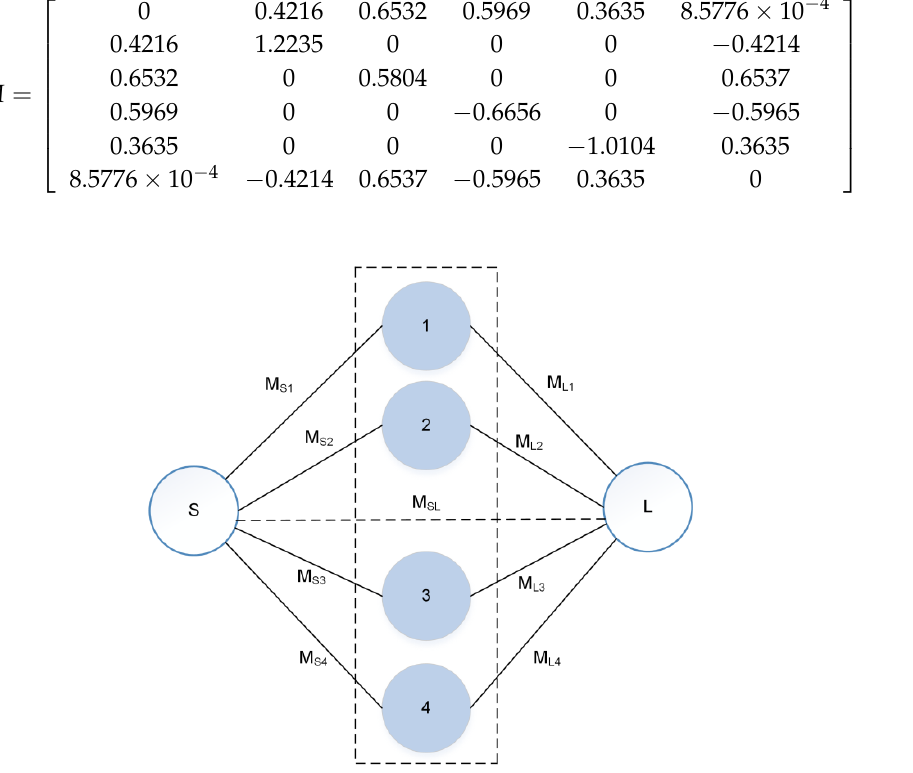
Figure 4. Coupling scheme of the quadruple-mode filter.